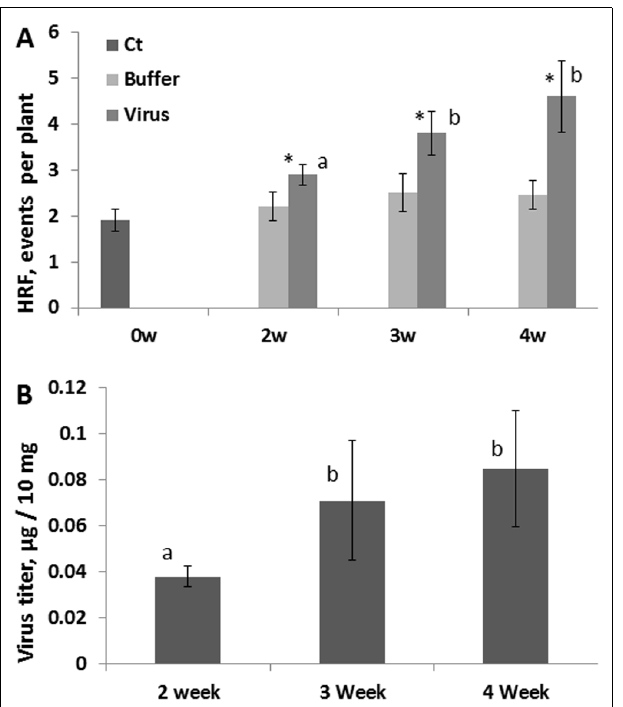
FIGURE 5 | HRF and viral titer in plants infected at different time points during development. Plants from line 15d8 were infected with 100 ng ORMV at 2, 3, and 4 weeks after germination. (A) HRF was analyzed in non-infected tissues 1 week after infection.The data are shown as the average HRF per plant (calculated from three repeats, each consisting of 20 plants, with SE). “0w” shows the HRF for control (Ct) – non-infected plants. “Buffer” and “Virus” show buffer-treated and virus-infected plants, respectively.The asterisks show significant differences between the virus- and buffer-treated groups ( P < 0.05).The letters indicate whether there is a significant difference between time points in the virus-treated groups. (B) A viral titer was measured in infected leaves at 48 hpi.The data are shown in microgram of ORMV per 10 mg of plant tissue (with SE). Four plants per each data point were analyzed.The letters indicate whether there is a significant difference between time points in the virus-treated groups.